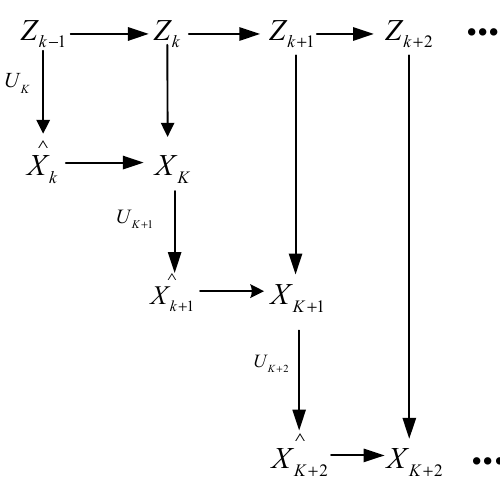
Figure 4. The process of solving the optimal value.